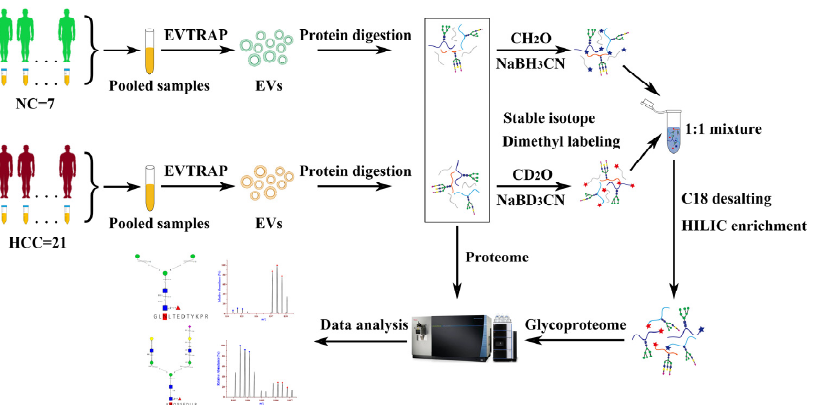
Figure 1. Workflow for the proteomic and glycoproteomic analysis of urinary EVs derived from patients with hepatocellular carcinoma and normal controls.